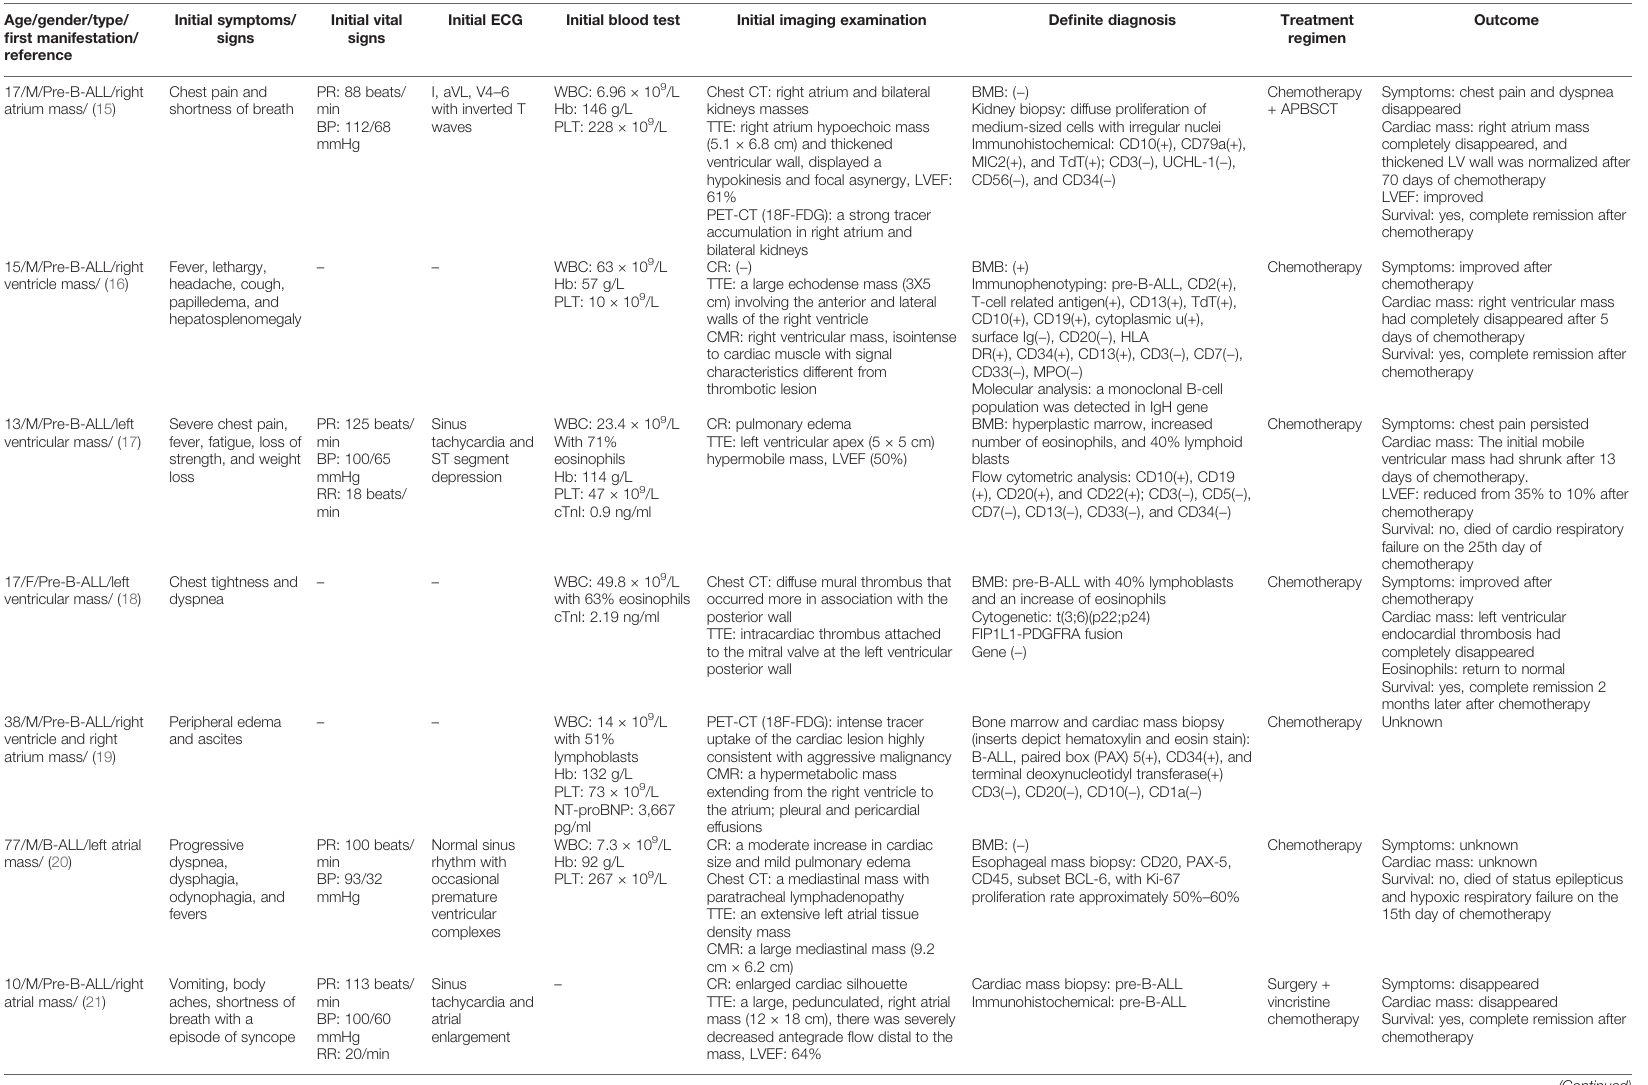
TABLE 2 | Cardiac mass as fi rst manifestation of acute lymphoblastic